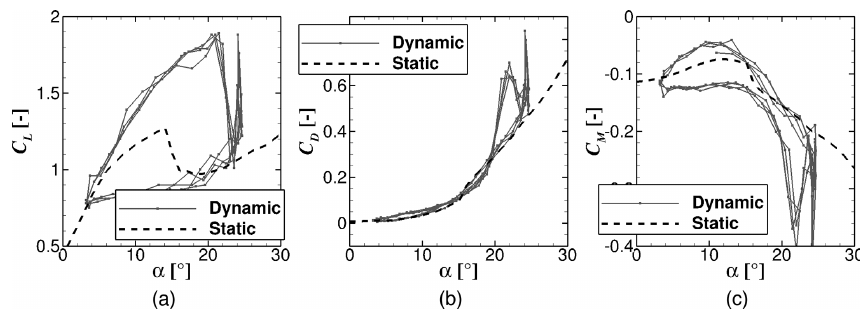
Figure 1. Typical dynamic stall behavior of S801 airfoil. Data obtained from Ramsay et al.